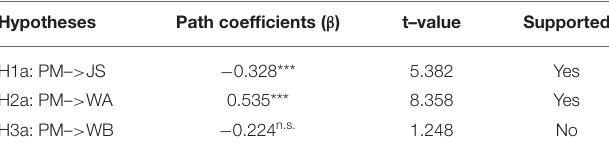
TABLE 7 | Summary of inner model results.